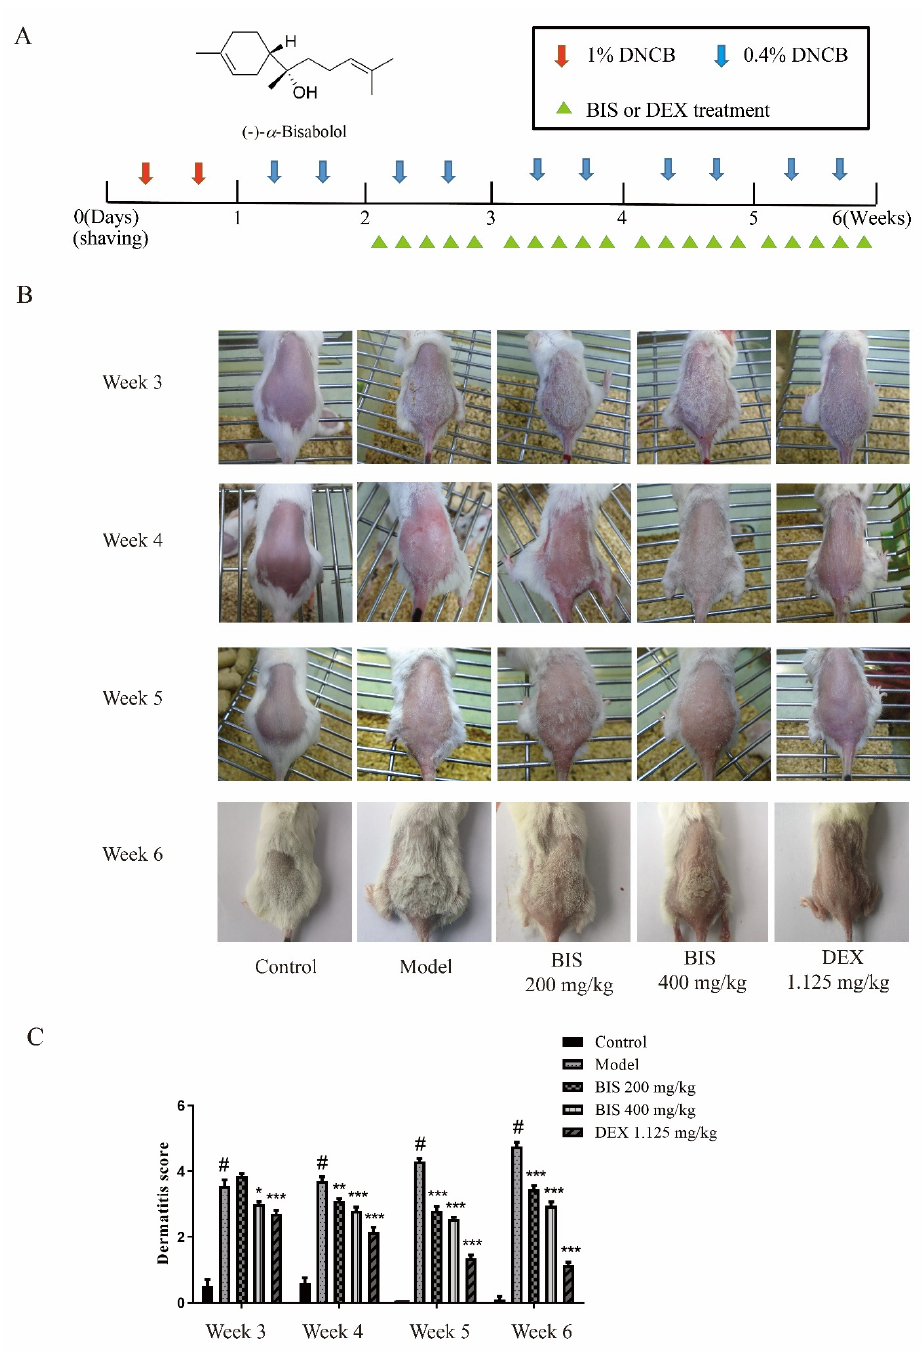
Figure 1. Chemical structure of BIS and effect of BIS on DNCB-induced AD-like skin symptoms. ( A ) Chemical structure of BIS and schematic diagram of the experimental schedule. ( B ) Clinical characteristics of each group on week 3–6. ( C ) The dermatitis scores of the AD-like skin lesions according to four major classes of symptoms. Data represent the mean ± SEM, n = 10 mice/group. # p < 0.05 vs. Control; * p < 0.05, ** p < 0.01, *** p < 0.001 vs.